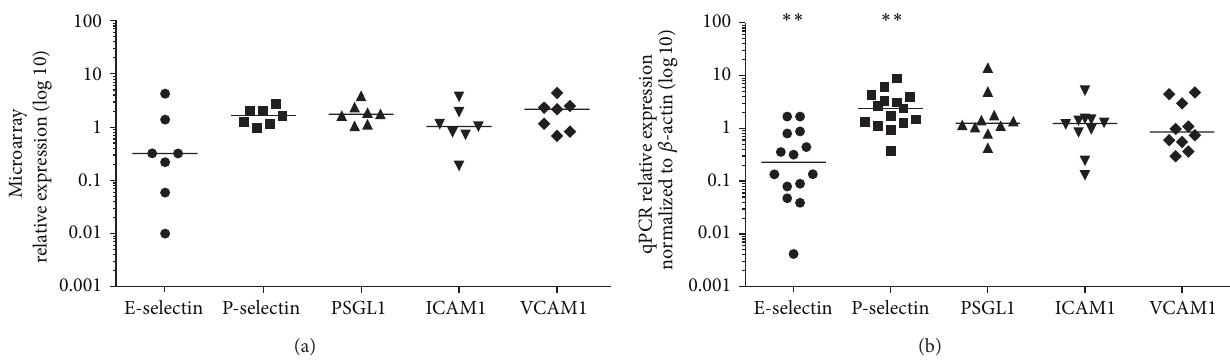
Figure 1: Scatter plots of adhesion molecule expression in nasal polyps compared to associated inferior turbinates using microarray and qPCR. Each single dot shows the relative expression of the target molecule in nasal polyps compared to associated inferior turbinates of one patient and median is indicated as horizontal bar . (a) Microarray analysis: nasal polyp tissues showed higher gene expression levels of the adhesion molecules P-selectin (1.62-fold, 𝑛 = 7 ), PSGL1 (1.74-fold, 𝑛 = 7 ), and VCAM1 (2.16-fold, 𝑛 = 7 ) compared to associated inferior turbinates. ICAM1 was unregulated (1.03-fold, 𝑛 = 7 ) and E-selectin was strongly downregulated in nasal polyps (0.32-fold, 𝑛 = 7 ). (b) qPCR analysis: lower median expression of E-selectin (0.22-fold, 𝑛 = 14 ) and higher median expression of P-selectin (2.37-fold, 𝑛 = 15 ) were observed in nasal polyps. The median expression of PSGL1, ICAM1, and VCAM1 showed no significant difference between nasal polyps and inferior turbinates: PSGL1 1.24-fold ( 𝑛 = 10 ), ICAM1 1.24-fold ( 𝑛 = 10 ), and VCAM1 0.85-fold ( 𝑛 = 10 ). The mRNA levels of E-selectin in nasal polyps decreased significantly ( 𝑃 = 0.004 ) compared to the inferior turbinates and P-selectin increased significantly ( 𝑃 = 0.0025 ). PSGL1, ICAM1, and VCAM1 were expressed at similar levels.